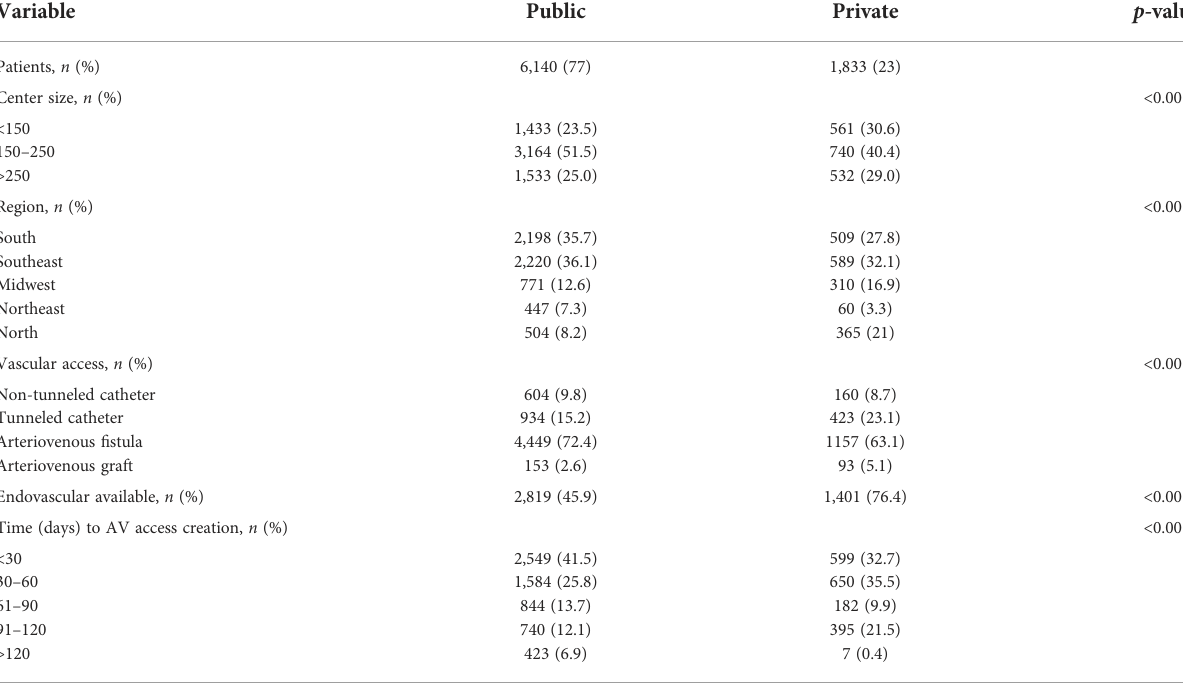
TABLE 3 Clinical and demographic characteristics of the patients strati fi ed by health insurance provider.